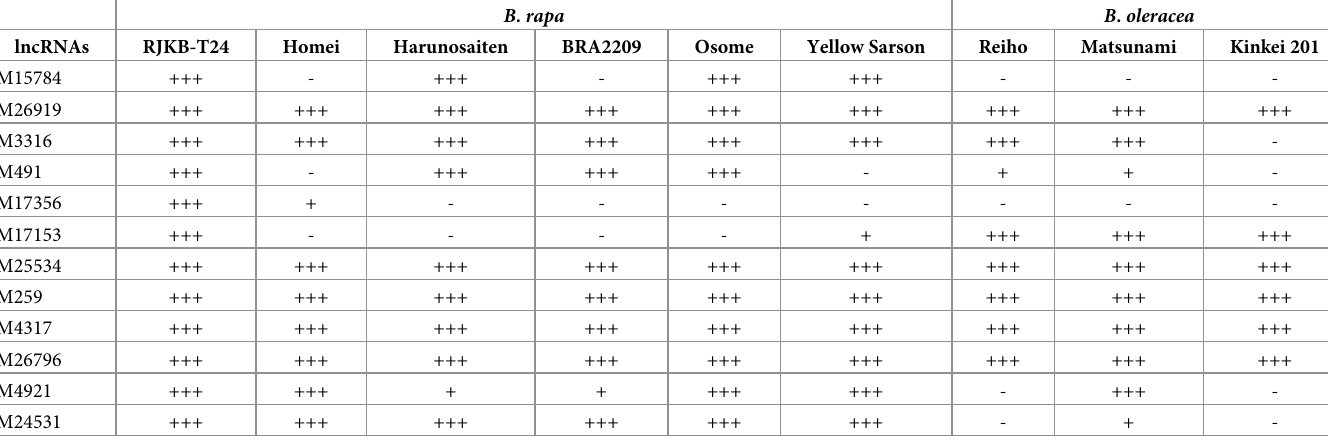
Table 1. Conservation and diversity of the expression of lncRNAs within B . rapa species or between